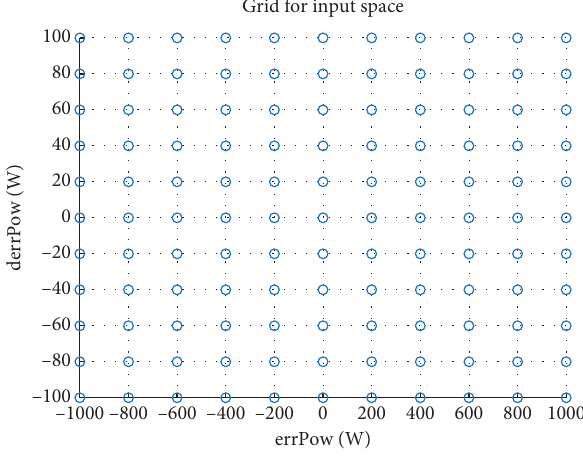
Figure 2: Gridding of the input space of the